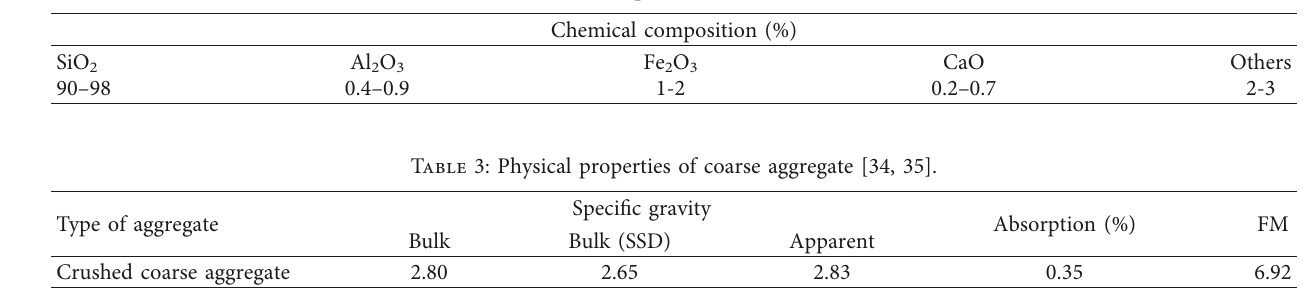
Table 2: Properties of microsilica.